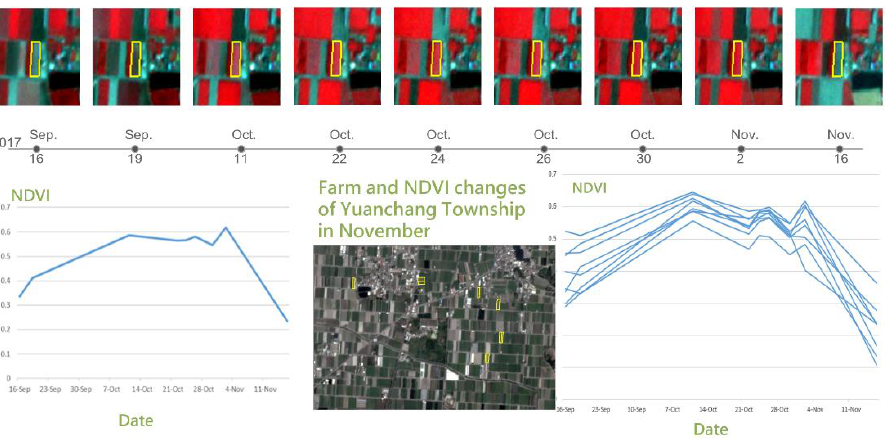
Figure 1. Multitemporal satellite image analysis.